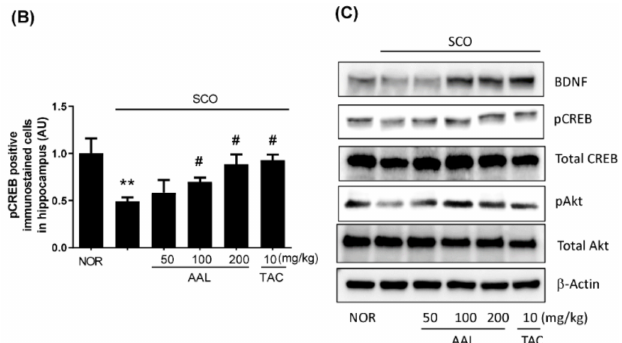
Figure 6. E ff ect of AAL extract on the levels of hippocampal BDNF, pCREB, and pAkt proteins in scopolamine-inducedcognitivedeficitmousebrains. RepresentativeimagesshowDABimmunostaining for phospho-CREB (pCREB) in the hippocampal region ( A ). The immunostained positive cells were calculated in brain tissue sections from each mouse ( B ). The graphs show the number of pCREB-positive cells in the hippocampal region. Data are presented as the mean ± SEM ( n = 3). ** p < 0.01 vs. NOR group, # p < 0.05 vs. SCO group. Hippocampus tissues were lysed and subjected to Western blotting with anti-BDNF, phospho-CREB, total CREB, phospho-Akt, and total Akt antibodies ( C ). The protein levels were normalized to total CREB, total Akt, and β -actin, respectively. NOR: normal control; SCO: scopolamine; AAL: A. atemoya leaf; TAC: